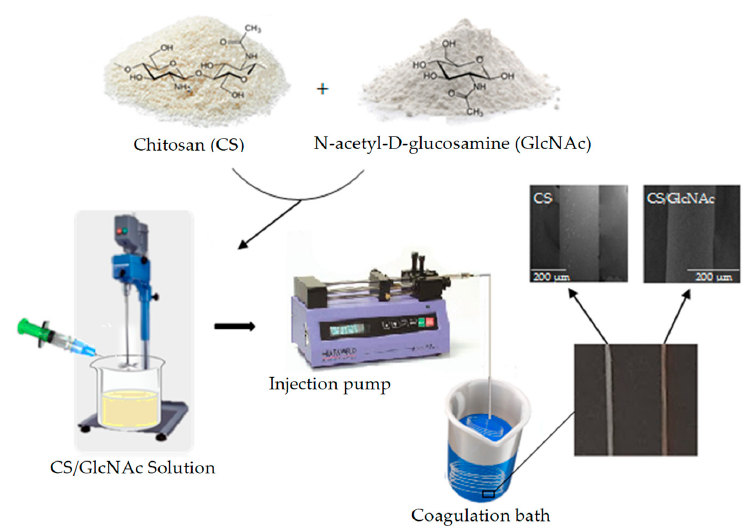
Figure 1. Schematic representation of the fabrication of chitosan (CS) and N-acetyl-D-Glucosamine (GlcNAc)-loaded CS wet-spun filaments.